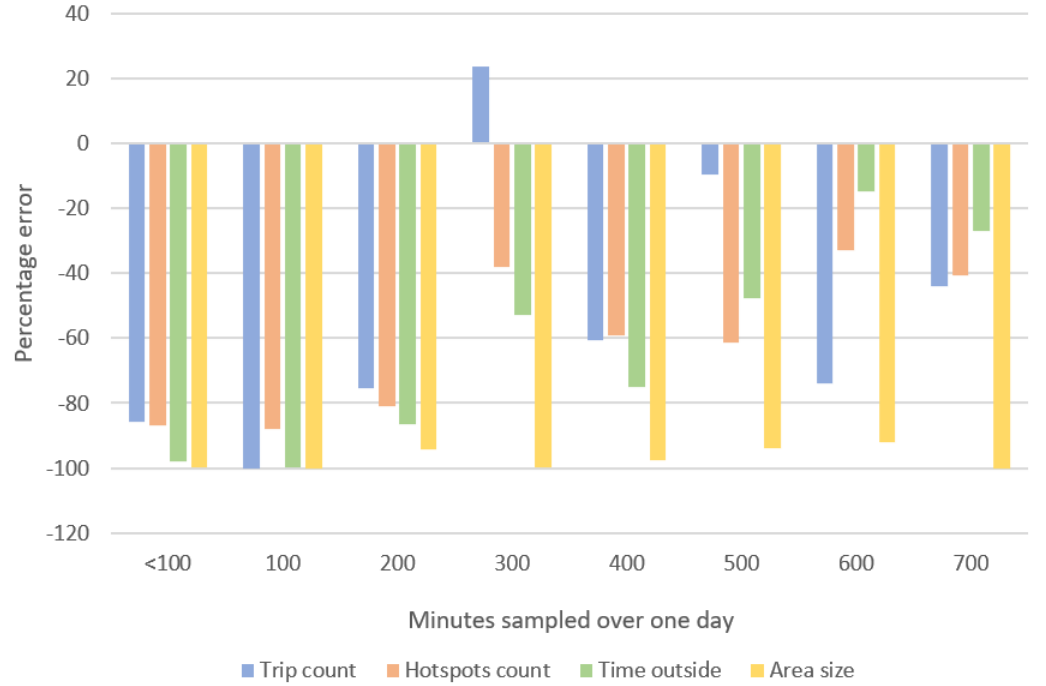
Figure 4. Percentage errors in mean daily, a. “time outside”, b. “trip count”, c. “hotspot count” and d. “area size” recorded during one day (total n = 14). The mean error rates over all subgroups were − 58.92 ± 32.12%, − 43.56 ± 41.77%, − 58.21 ± 22.62% and − 97.18 ± 3.02%, respectively.